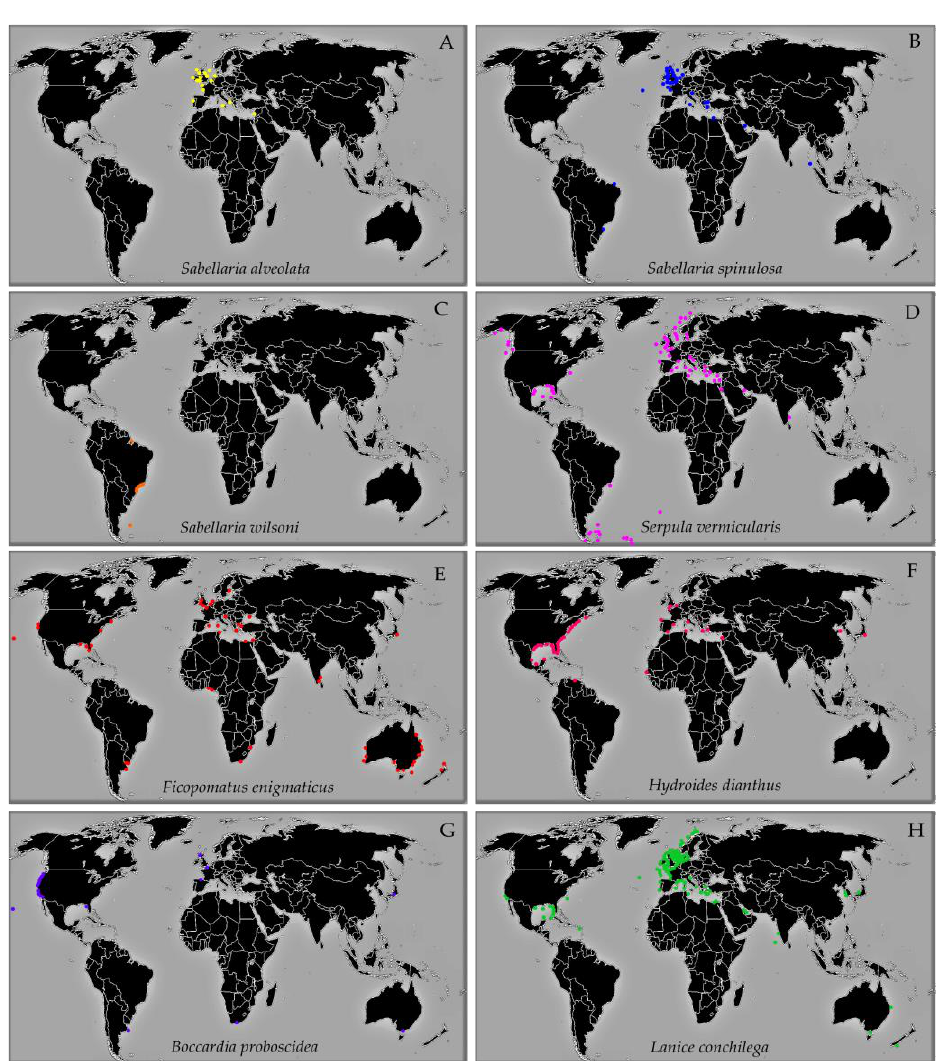
Figure 1. Maps showing the geographical distribution of the reef-building polychaetes (RBP). Point occurrence data were extracted from the Ocean Biogeographic Information System (OBIS) database (https: // www.iobis.org) on 7 August 2019. Occurrence data were compared with the World Register of Marine Species (WoRMS) database (https: // www.worms.org / , downloaded on 7 August 2019) and from The Marine Life Information Network, Marine Biological Association of the United Kingdom (https: // www.marlin.ac.uk). ( A ) Sabellaria alveolata, ( B ) Sabellaria spinulosa, ( C ) Sabellaria wilsoni, ( D ) Serpula vermicularis , ( E ) Ficopomatus enigmaticus , ( F ) Hydroides dianthus, ( G ) Boccardia proboscidea , ( H ) Lanice conchilega.